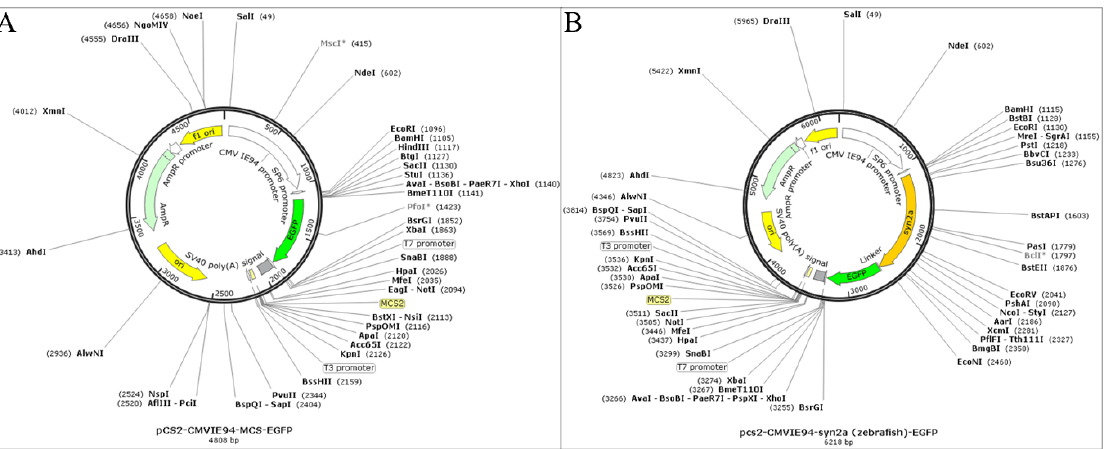
Figure 7. The construction of plasmid vector ( A ) and syn2a overexpression plasmid (pCS 2+ - CMVIE94-syn2a (zebrafish)-EGFP plasmid) ( B ). In the structural map of plasmids, some restriction sites (in gray) are marked with an asterisk in the upper right corner, indicating that there is more than a single restriction site. Restriction sites marked with an asterisk are generally not selected.